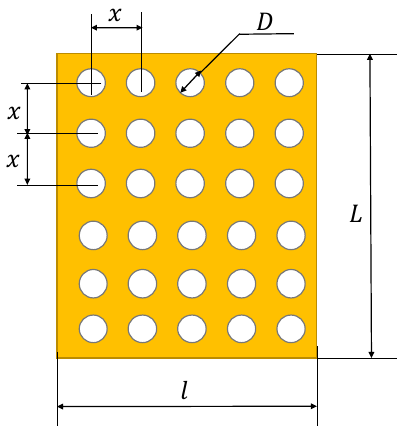
Figure 2. Panel with perforated horizontal orifices.